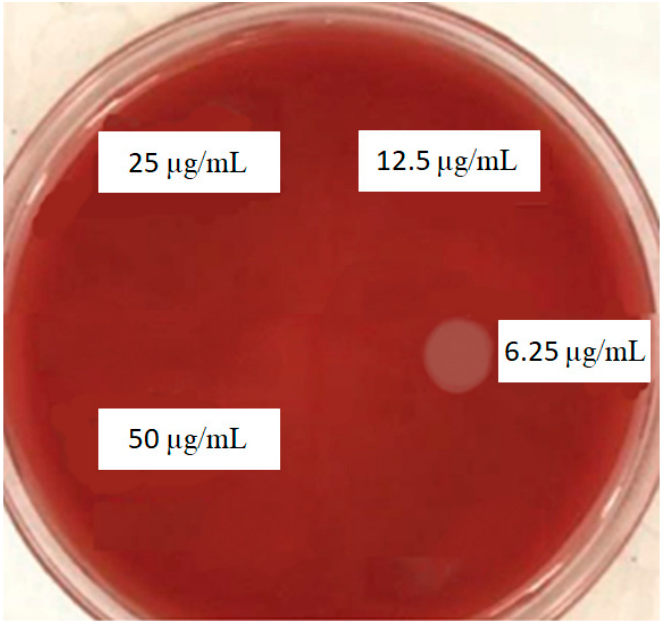
Figure 4. MBC results for curcumin nanoparticles against P. gingivalis.